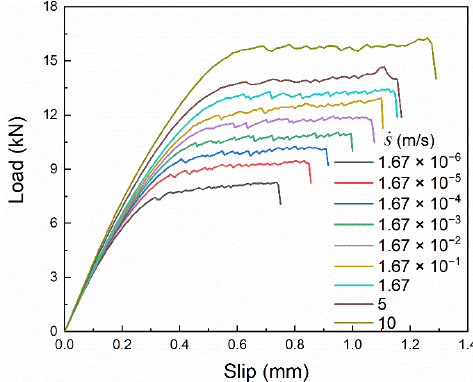
Figure 23. Verification of empirical formulas: ( a ) the maximum bond stress; ( b ) the slip at the maximum bond stress.